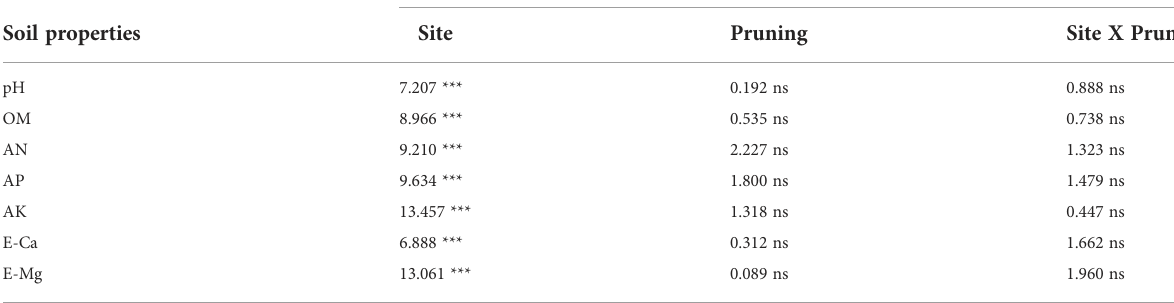
TABLE 1 Tow-way ANOVA of soil fertility properties in representative sites.